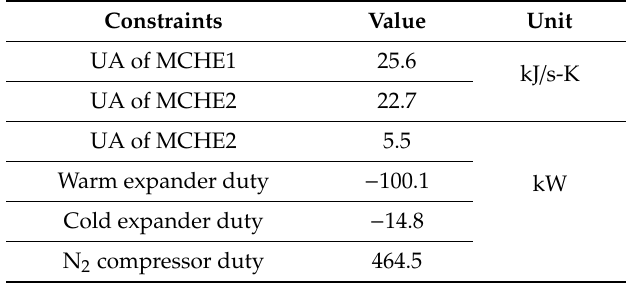
Table A2. Additional constraints for dual nitrogen expansion.